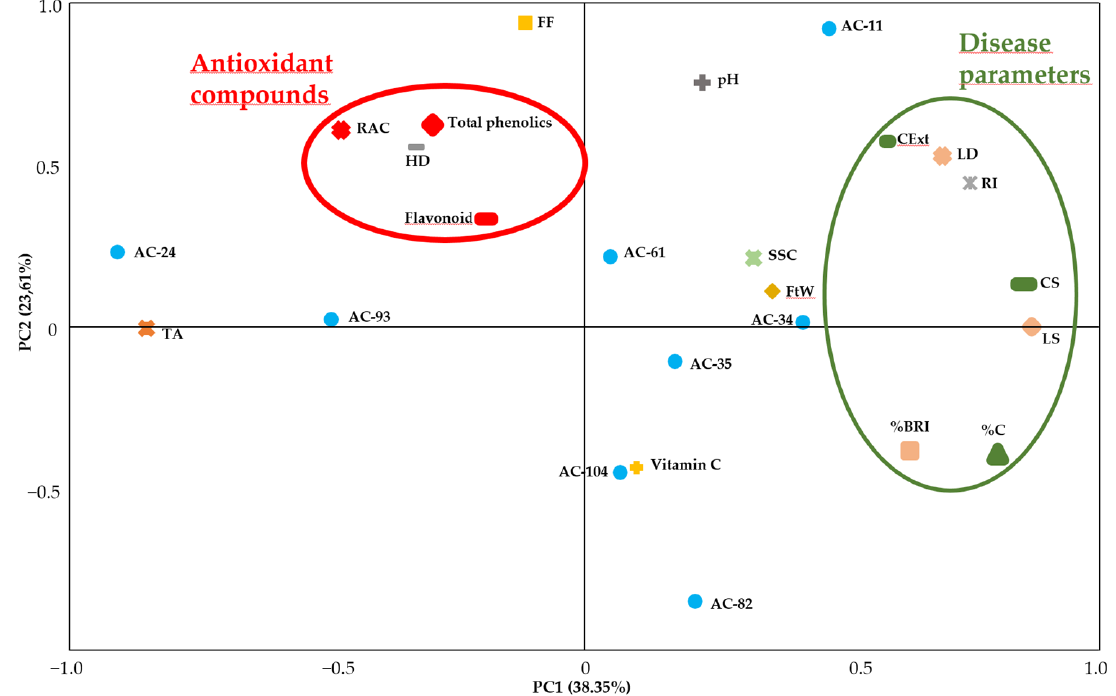
Figure 2. Principal Component Analysis (PCA) of eight genotypes from the ‘Andross’ × ‘Calante’ population evaluated in 2014 and 2015 and the studied variables. The genotypes are represented as (AC-). The red oval groups the antioxidant parameters and the green the disease parameters of the eight selected genotypes. Abbreviations: HD = Harvest date; FtW = Fruit weight; FF = Fruit firmness; SSC = Soluble solids content; TA = Titratable acidity; RI = Ripening index; RAC = Relative antioxi- dant capacity; BRI = Brown Rot Incidence; LD = Lesion diameter; LS = Lesion severity; C = Coloni- zation; CExt = Colonization extent; CS = Colonization severity.